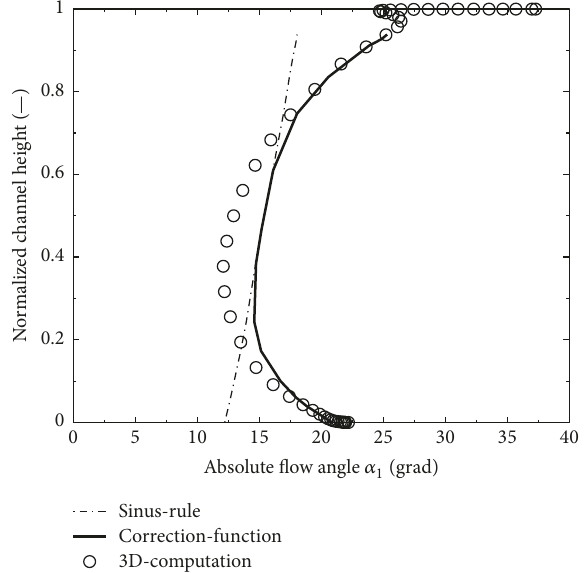
Figure 18: Validation of the deflection model of (25) over the blade height for the curvature blade 𝐵𝑜𝑤 𝐹32𝑔